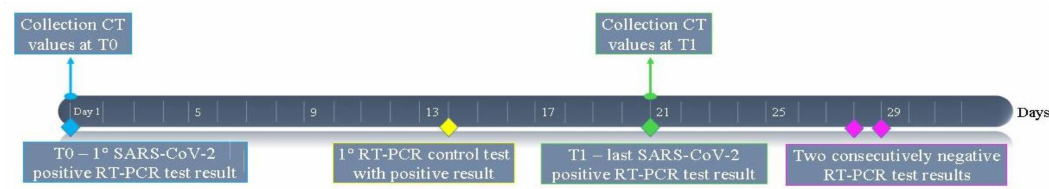
Figure 2. Timeline of cycle threshold (CT) value collection. An example according to a time length of negativization of 4